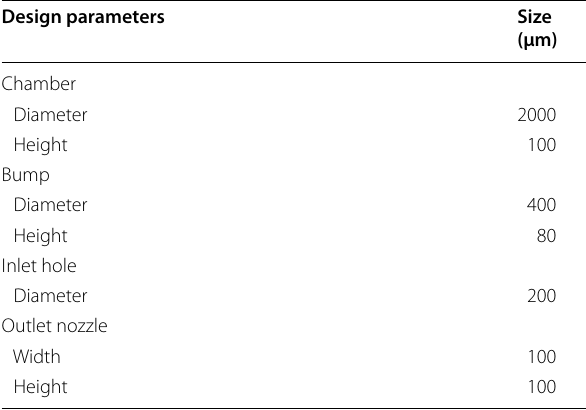
Table 1 Summary of design parameters